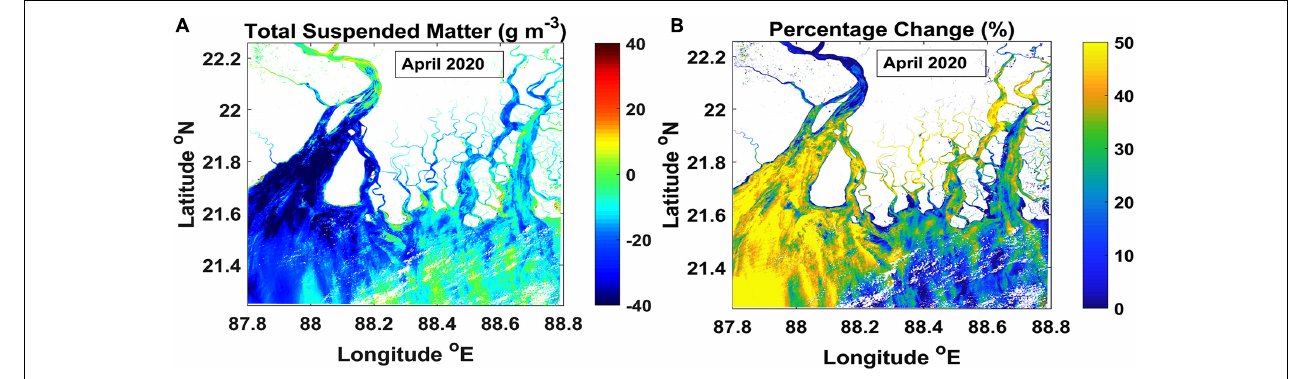
FIGURE 6 | (A) Total suspended matter anomaly during April 2020. (B) Percentage decrease of TSM with respect to the 5-years